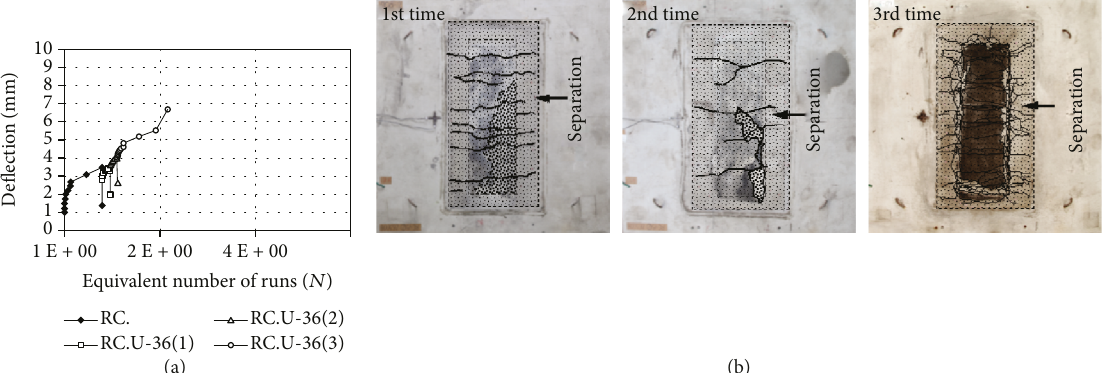
Figure 7: RC-U-36. (a) Relationship between de fl ection and number of equivalent cycles. (b) Condition of damage caused on the upper surface.